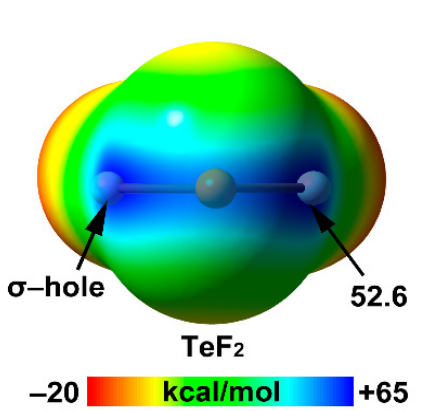
Figure 13. ( a ) Schematic representation of compound 24 (PTBP stands for para -tercbutylphenyl) and ( b ) its MEP surface at the B3LYP/def2-TZVP level of theory. The energy value at the selected point of the surface is given in kcal/mol (0.001 a.u.).